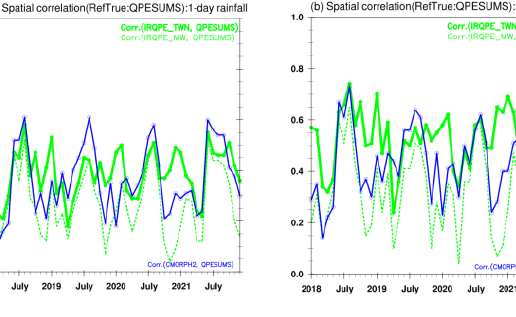
Figure 13. The spatial correlation with the ground truth (QPESUMS) from IRQPE (solid green: IRQPE_TWN, dashed green: IRQPE_MW) and CMORPH2 (blue) for 4-time scale data: ( a ) 1-day, ( b ) 5-day, ( c ) 10-day, ( d ) 30-day.